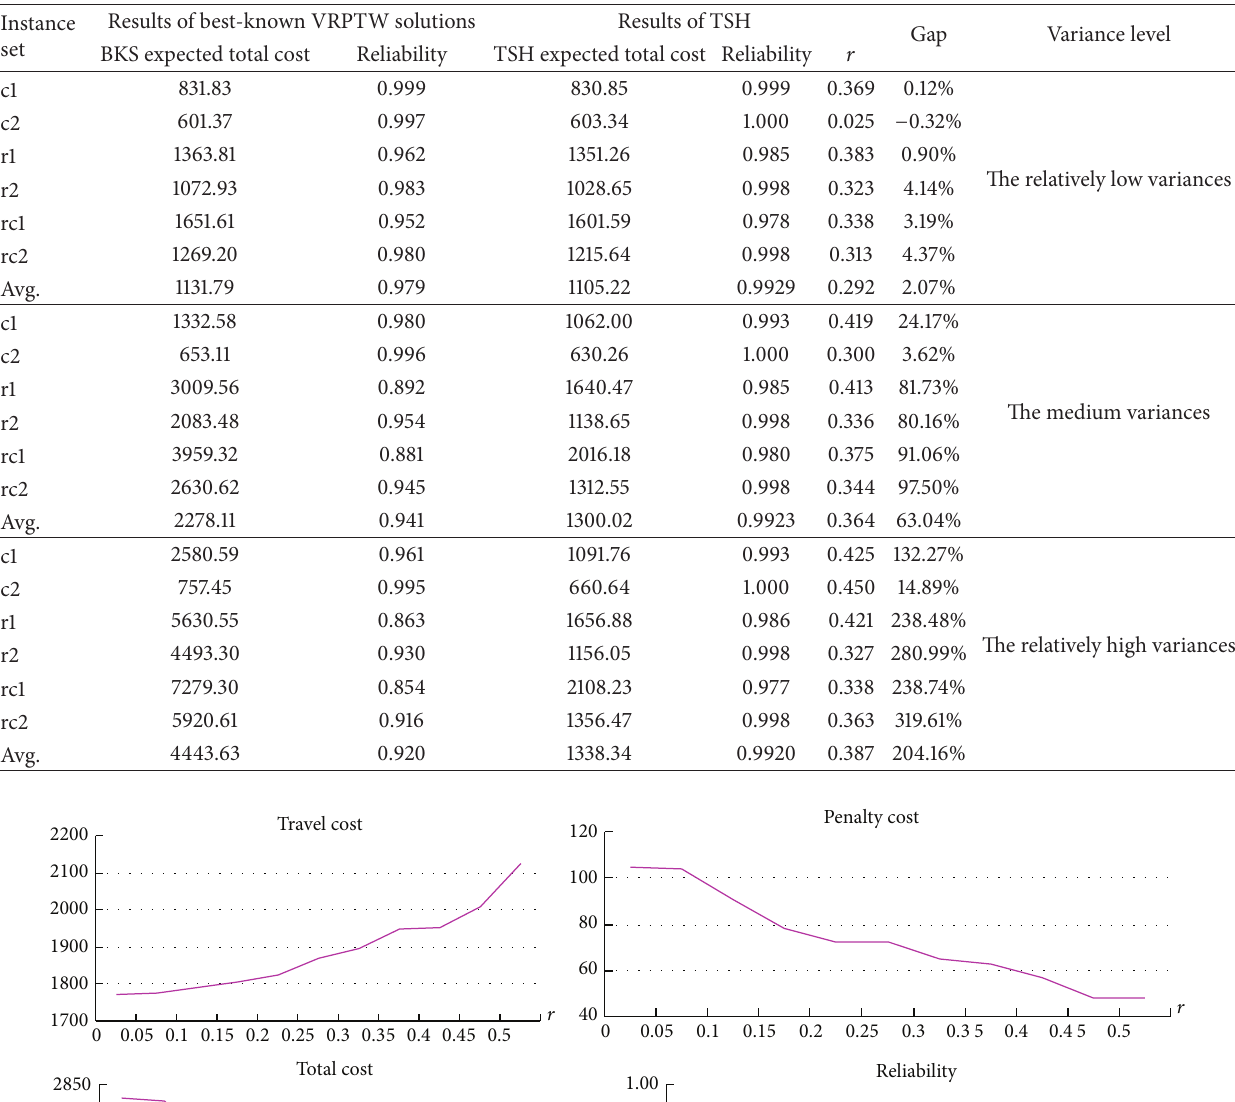
Table 3: Average results for each instance set under three variance levels.